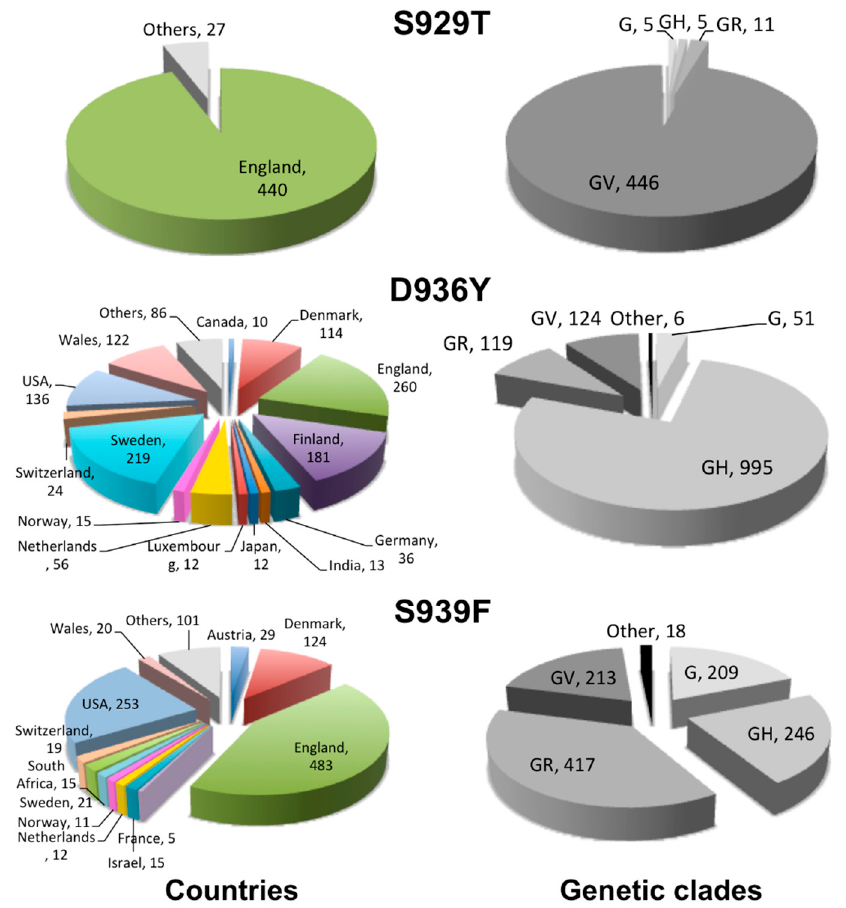
Figure 2. Countries and genetic clades. Pie chart visualization of the geographical distribution (left panel) and phylogenetic classification (right panel) of sequences presenting the S929T, D936Y, and S939F mutations.